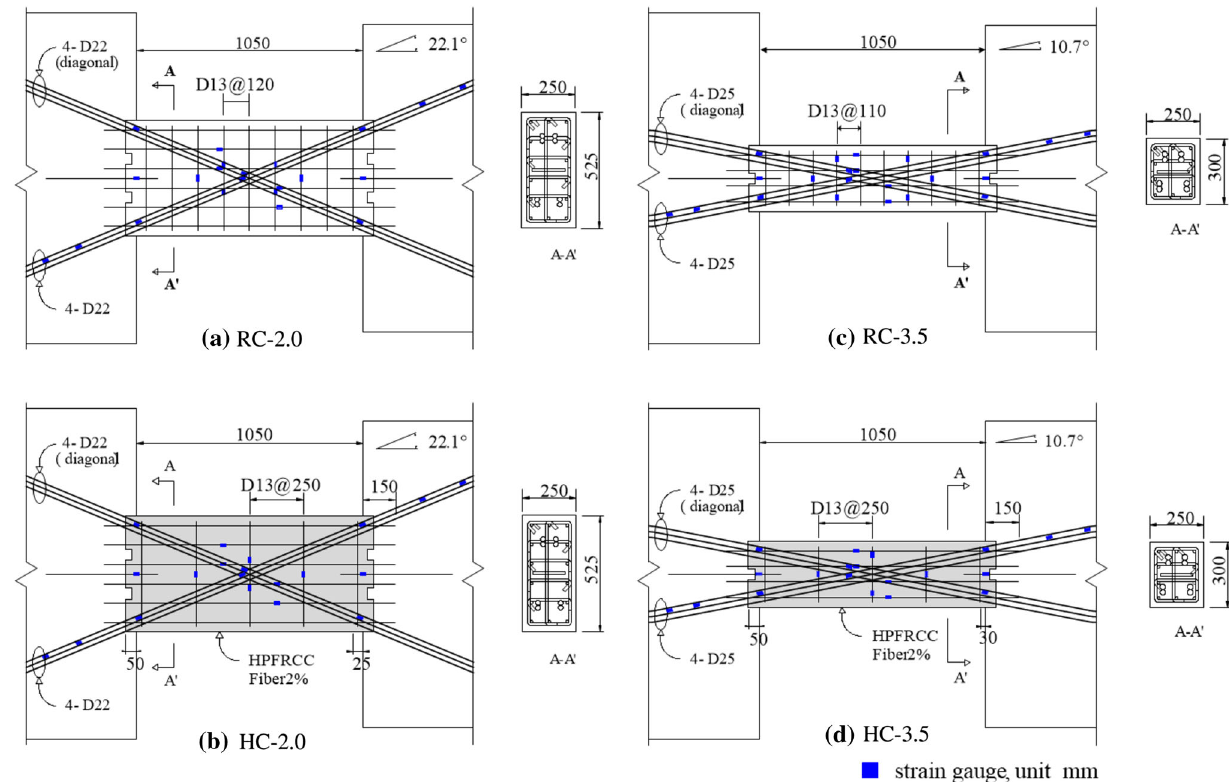
Fig. 2 Dimensions and reinforcing details of coupling beam